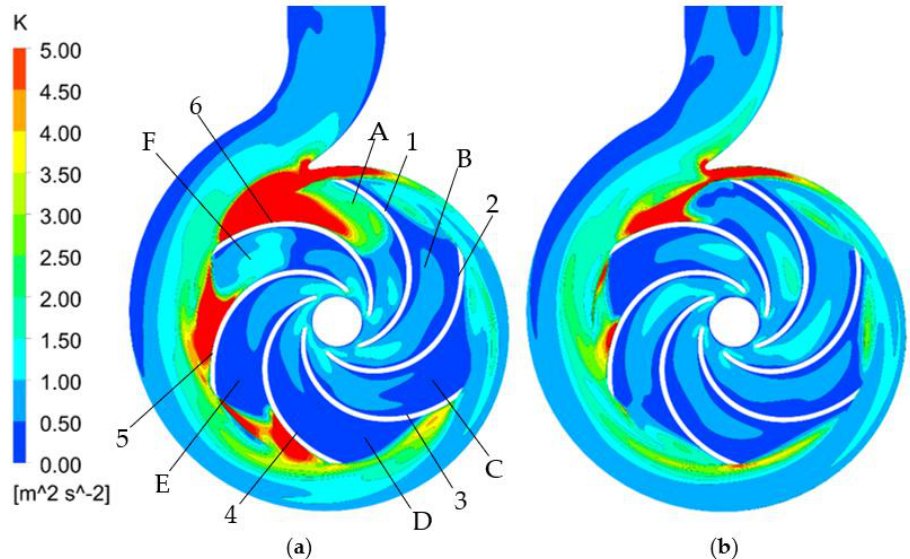
Figure 16. Turbulent kinetic energy distribution in axial plane b under part load conditions. ( a ) 0.2Qd, ( b ) 0.4 Qd.